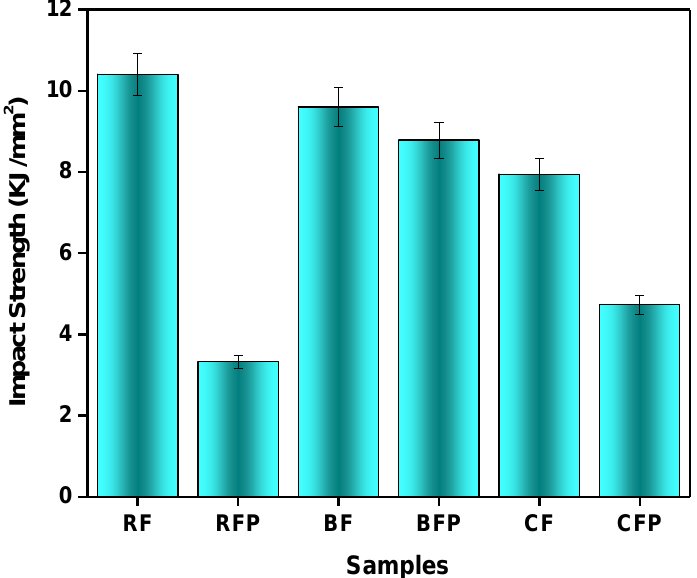
Figure 4. Impact strength comparison of the composites.